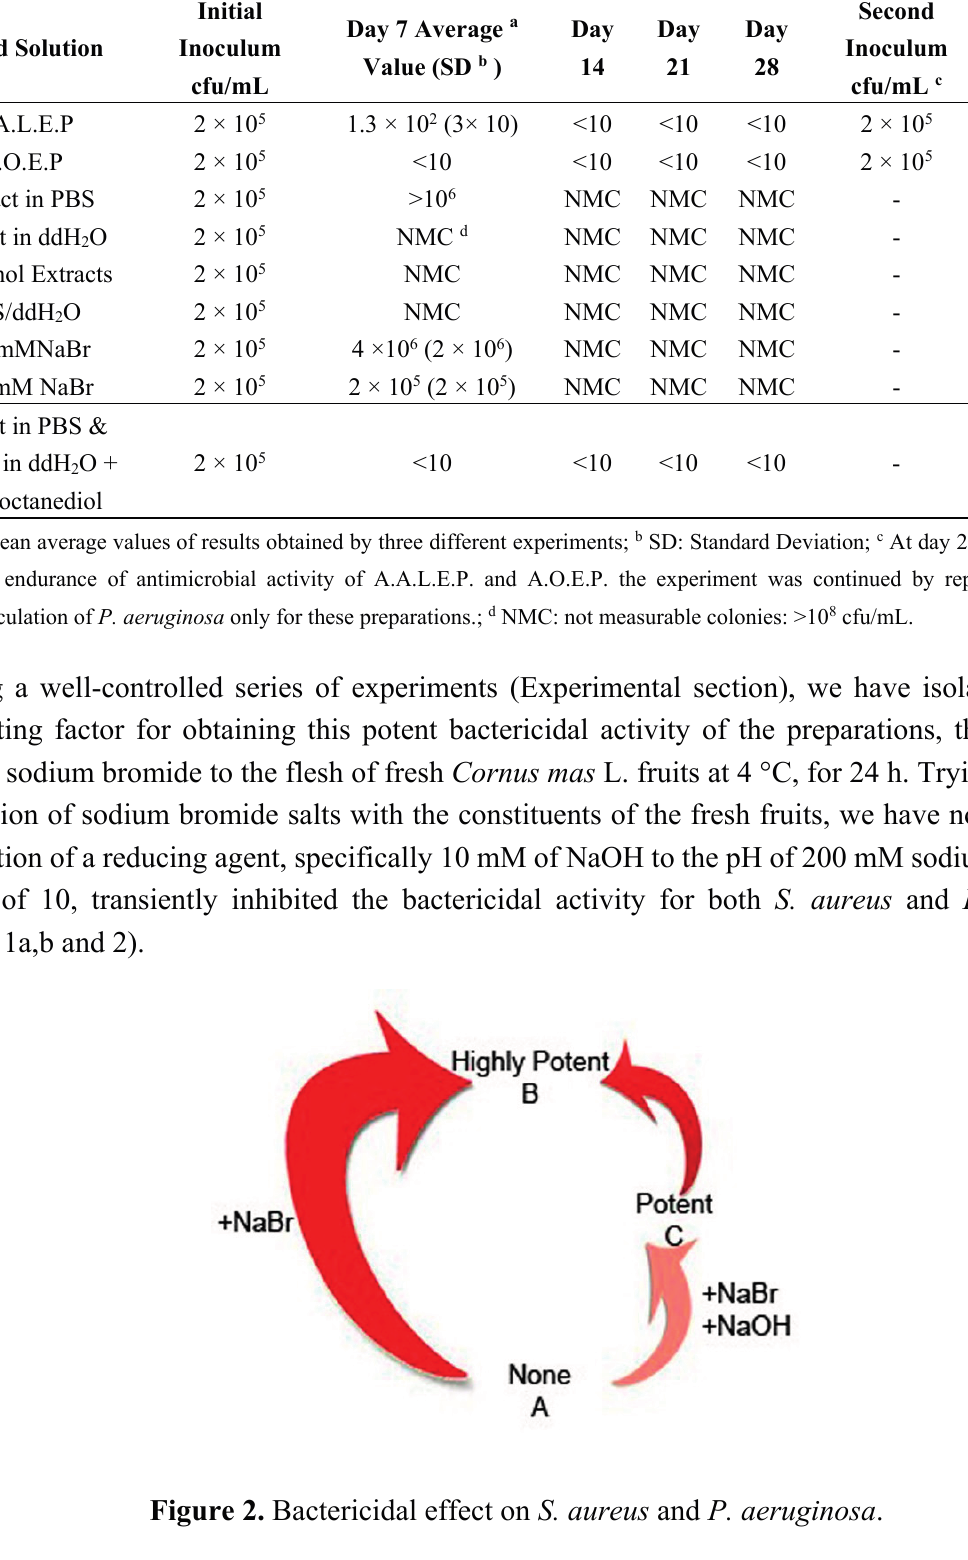
Table 2. Bactericidal activity of different Cornus mas L. extracts against P. aeruginosa . Tested Solution